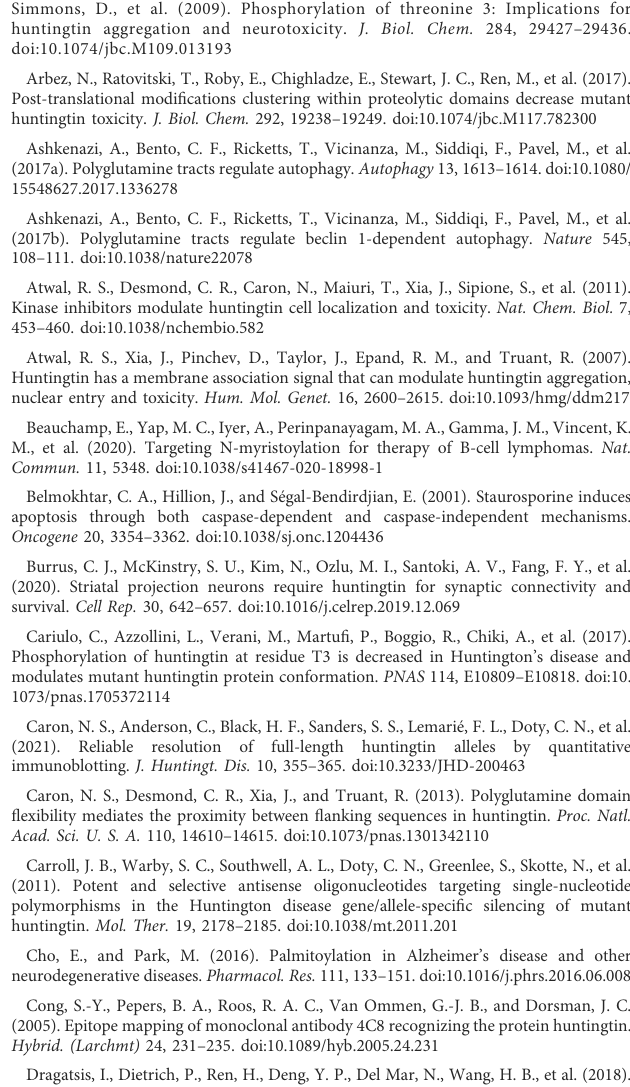
labeling assay in HEK293 cells transfected with C-terminal HTT553-3144- EGFP WT or G553A. SUPPLEMENTARY FIGURE S8 Uncropped blots used for Figure 4D displaying total (D7F7/green channel) and myristoylated HTT (Streptavidin/red channel) measured by bio-orthogonal labelingassayinHeLacellstransfectedwithmCherry-23Q-HTT1-3144-EGFP constructs WT, G553A, or TEV552. SUPPLEMENTARY FIGURE S9 Uncropped blots used for Figure 5B displaying total (D7F7/green channel) and myristoylated HTT (Streptavidin/red channel) measured by bio-orthogonal assayinHeLacellsweretransfected withmCherry-23QandmCherry-100Q- HTT1-3144-EGFP constructs WT or TEV586. SUPPLEMENTARY FIGURE S10 Uncropped blots used for Figure 6A displaying immunoprecipitated full length and C-term HTT (GFP/green channel; MAB2166/red channel) and co- immunoprecipitated N terminal HTT (MAB166/red channel; mCherry/green channel) in HeLa cells transiently expressing mCherry-23Q-HTT1-3144-EGFP WT, TEV586, TEV552 or